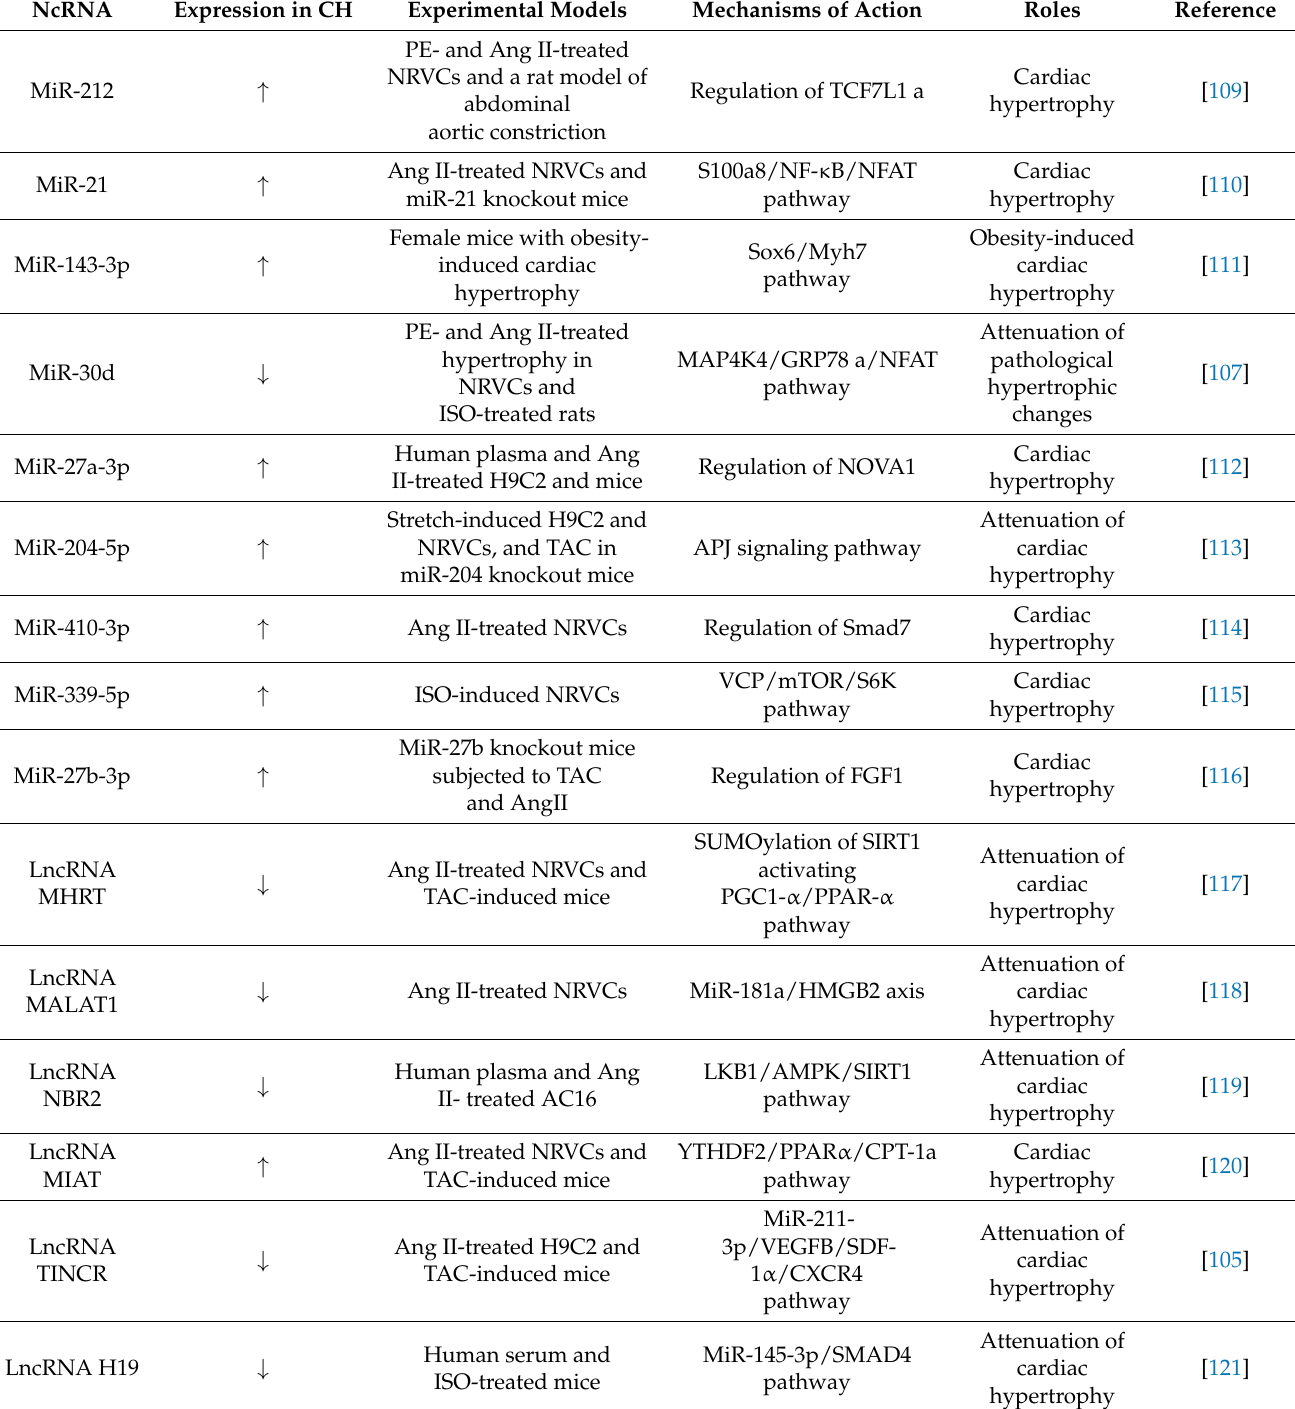
Table 2. Noncoding RNAs in cardiac hypertrophy